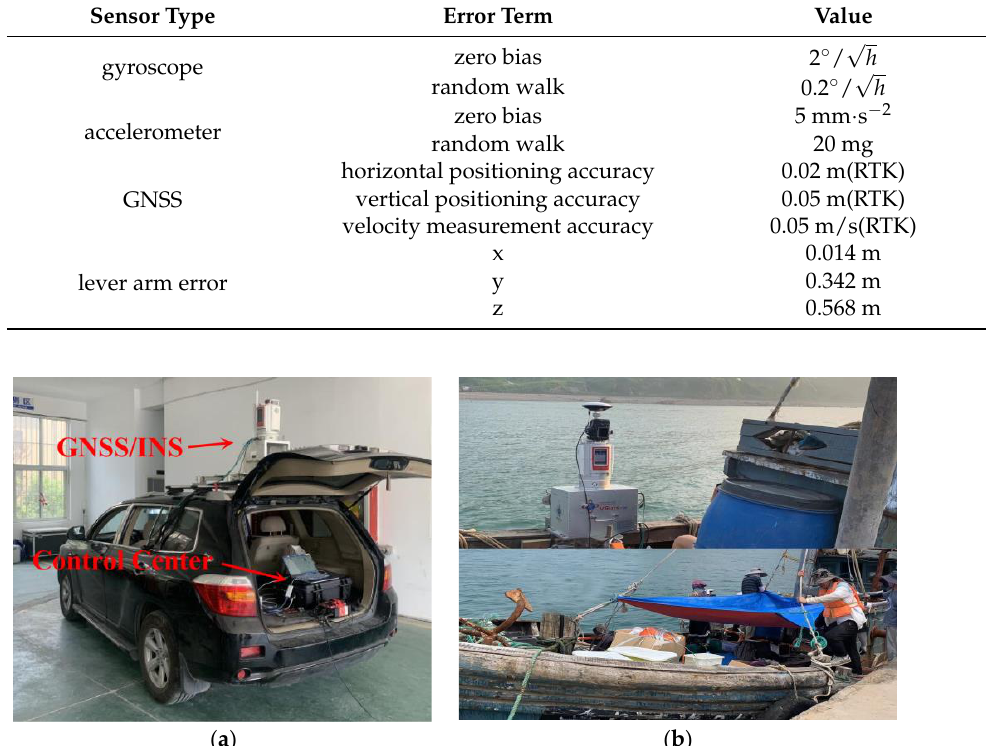
Table 2. Navigation and positioning sensor parameters.